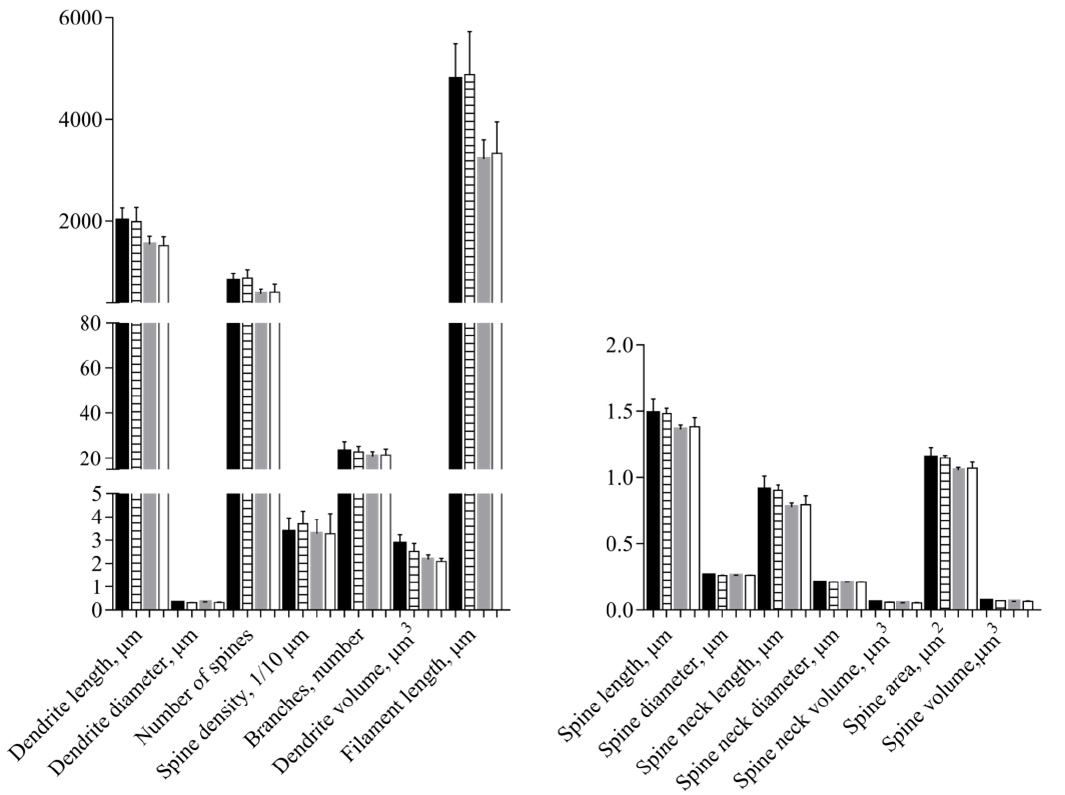
Figure 5. Morphological analyses of apical and basal dendrites of pyramidal neurons in the cornu ammonis 1 of the hippocampus. Control animals (apical—black; basal—gray) and severely vitamin C deficient animals (apical—horisontal stripes; basal—white). No influence of vitamin C deficiency was detected in the morphological parameters, except for a slight decrease in apical dendrite volume ( p = 0.0488). t -Test or Welch’s t -test, mean ± SD. Each experimental group consisted of 10 animals and from each animal 5–7 pyramidal neurons situated within the stratum pyramidale of cornu ammonis 1 were analyzed for morphological changes and the data averaged.